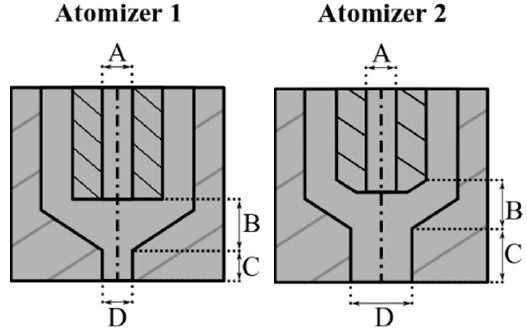
Figure 1. Schemes of used air-core-liquid-ring atomizers 1 and 2. Dimensions of gas capillary diameter (A) and length of the mixing zone (B), as well as length (C) and diameter (D) of the exit orifice are given in Table 2. Table 2. Dimensions of the used Air-core-liquid-ring (ACLR) atomizers: gas capillary diameter (A), length of the mixing zone (B), length of the exit orifice (C) and diameter of the exit orifice (D).